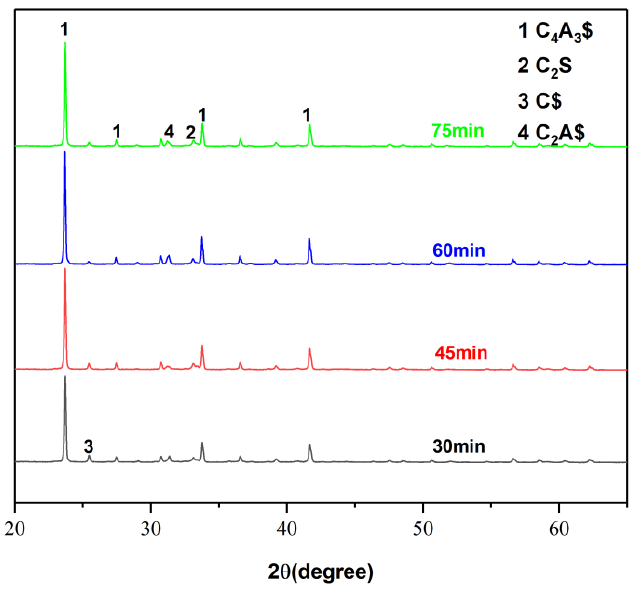
Figure 12. XRD patterns of S2 samples at different times.